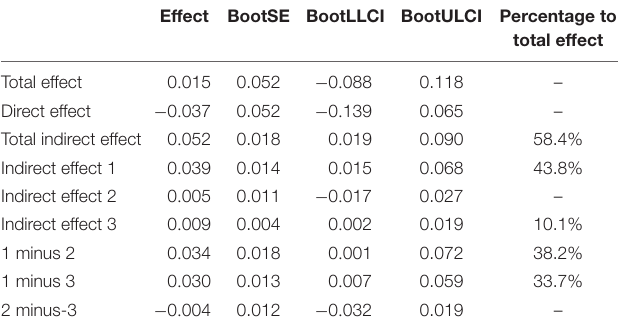
TABLE 3 | Regression analysis results.